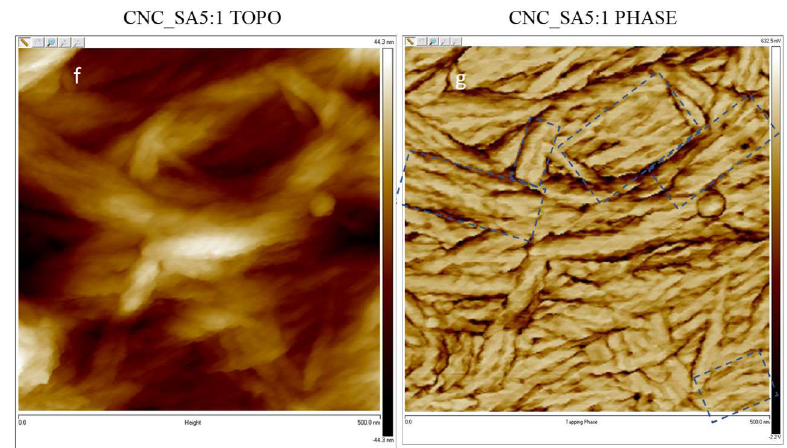
Figure 9. Representative AFM topography and phase images of CNC-P76 at scanning areas of ( a , b ) 2 × 2 µ m, and ( c , d ) 500 × 500 nm, and ( f , g ) CNC-SA 5:1 at scanning area of 500 × 500 nm samples; ( e ) cross-sectional profiles taken from the CNC-P76 topography image.